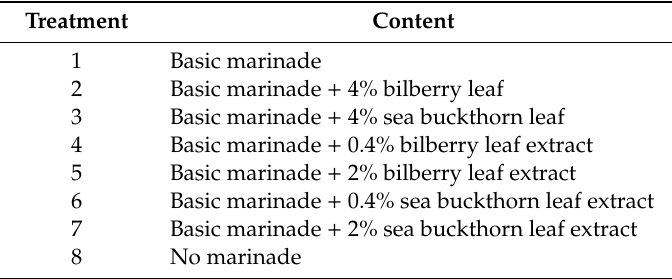
Table 2. Chicken leg marinade